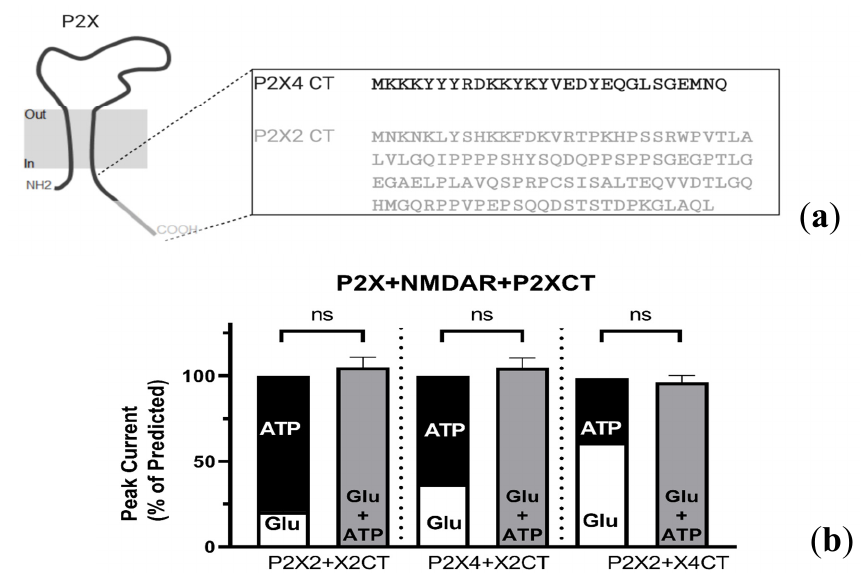
Figure 5. P2X c-terminus (CT) mediate interactions with NMDARs. ( a ) Top: A representative illustration of a homotrimeric P2X. The insert illustrates the di ff erences in the size of the P2X4 (black) and P2X2 (grey) CT. ( b ) Bar graphs representing the predicted and actual responses obtained from coapplication of Glu (2 µ M) and ATP (5 µ M) in oocytes expressing either the P2X2 CT or the P2X4 CT, in